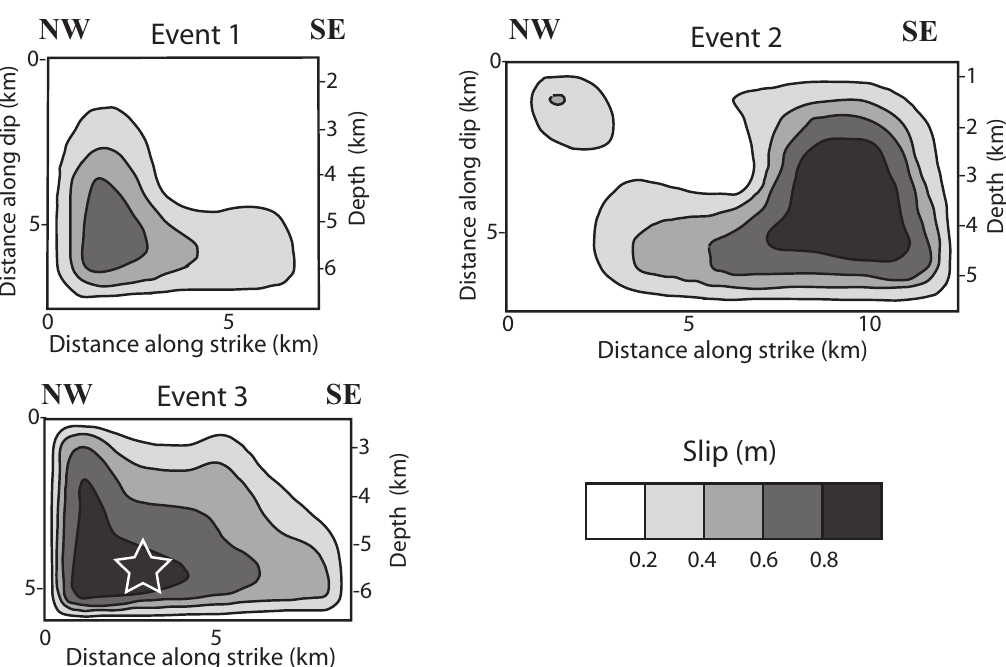
Fig. 6. Best fit model for slip distribution of events 1-3 from inversion of geodetic data (Hernandez et al. , 2004). A joint inversion of DInSAR and GPS data is performed in case of events 1 and 2 (see fig. 3), while event 3 rupture is inverted from DInSAR data alone. The open white star indicates the hypocenter on the fault plane of event 3. The crustal model used is reported in table I. Figure redrawn after Hernandez et al .